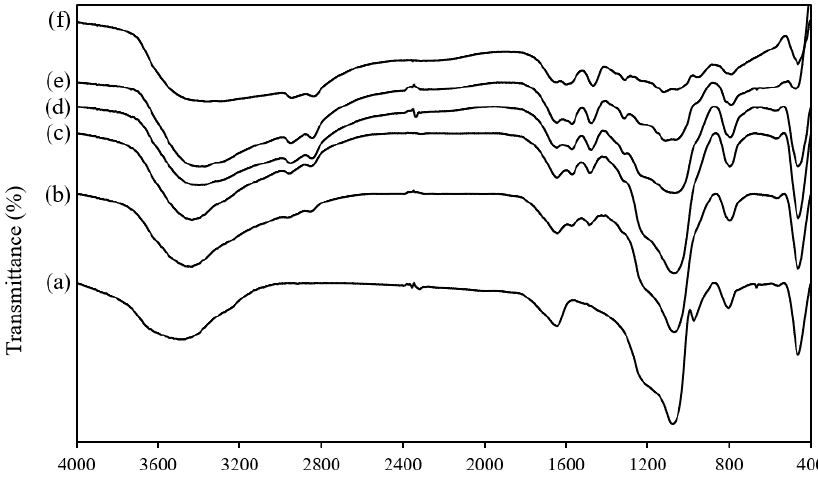
Figure 3. XRD diffraction patterns of ( a ) unfunctionalized MSU-2 and MSU-2 functionalized with TEPA loadings of ( b ) 20 wt%, ( c ) 30 wt%, ( d ) 40 wt%, ( e ) 50 wt%, and ( f ) 60 wt%.